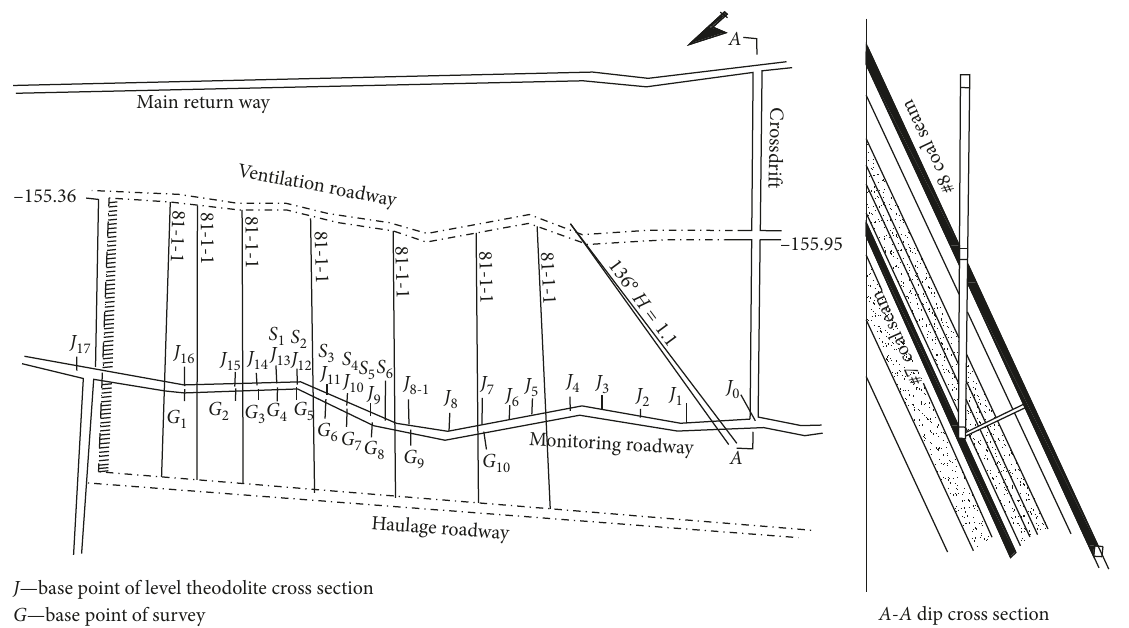
Figure 14: Arrangement of the rock movement observation boreholes (adaptation).